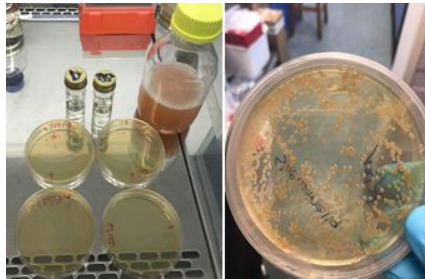
Figure 2. Serial dilution of the bio-agent.